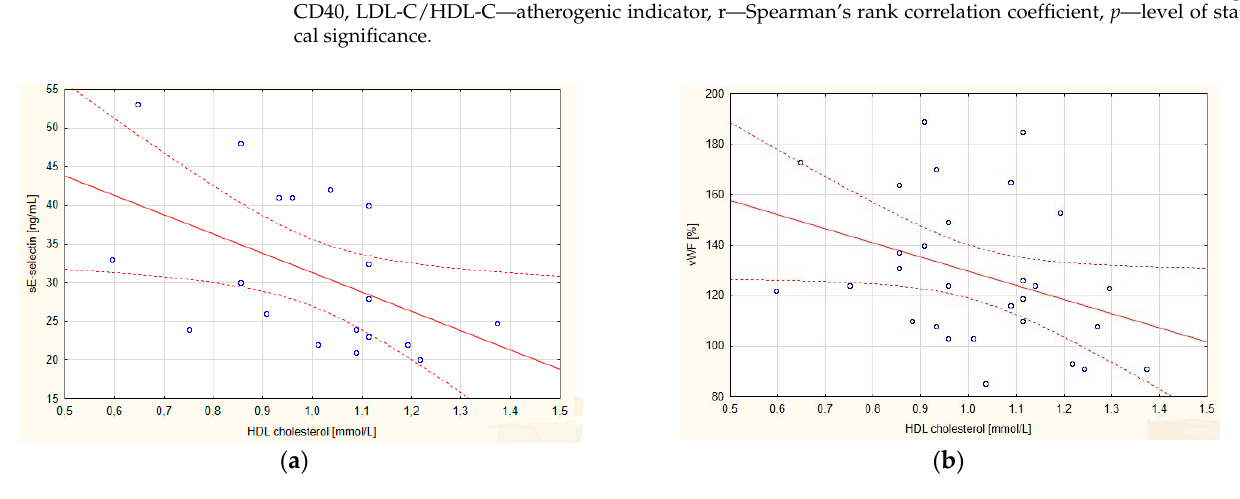
Figure 4. Correlations in the group of patients with stable angina (SA) between the high-density lipoprotein cholesterol (HDL-C) fraction and ( a ) soluble E-selectin (sE-selectin) and ( b ) von Willebrand factor (vWF). The regression line is marked with a solid line, while the confidence intervals of 0.95 are marked with a dashed line.